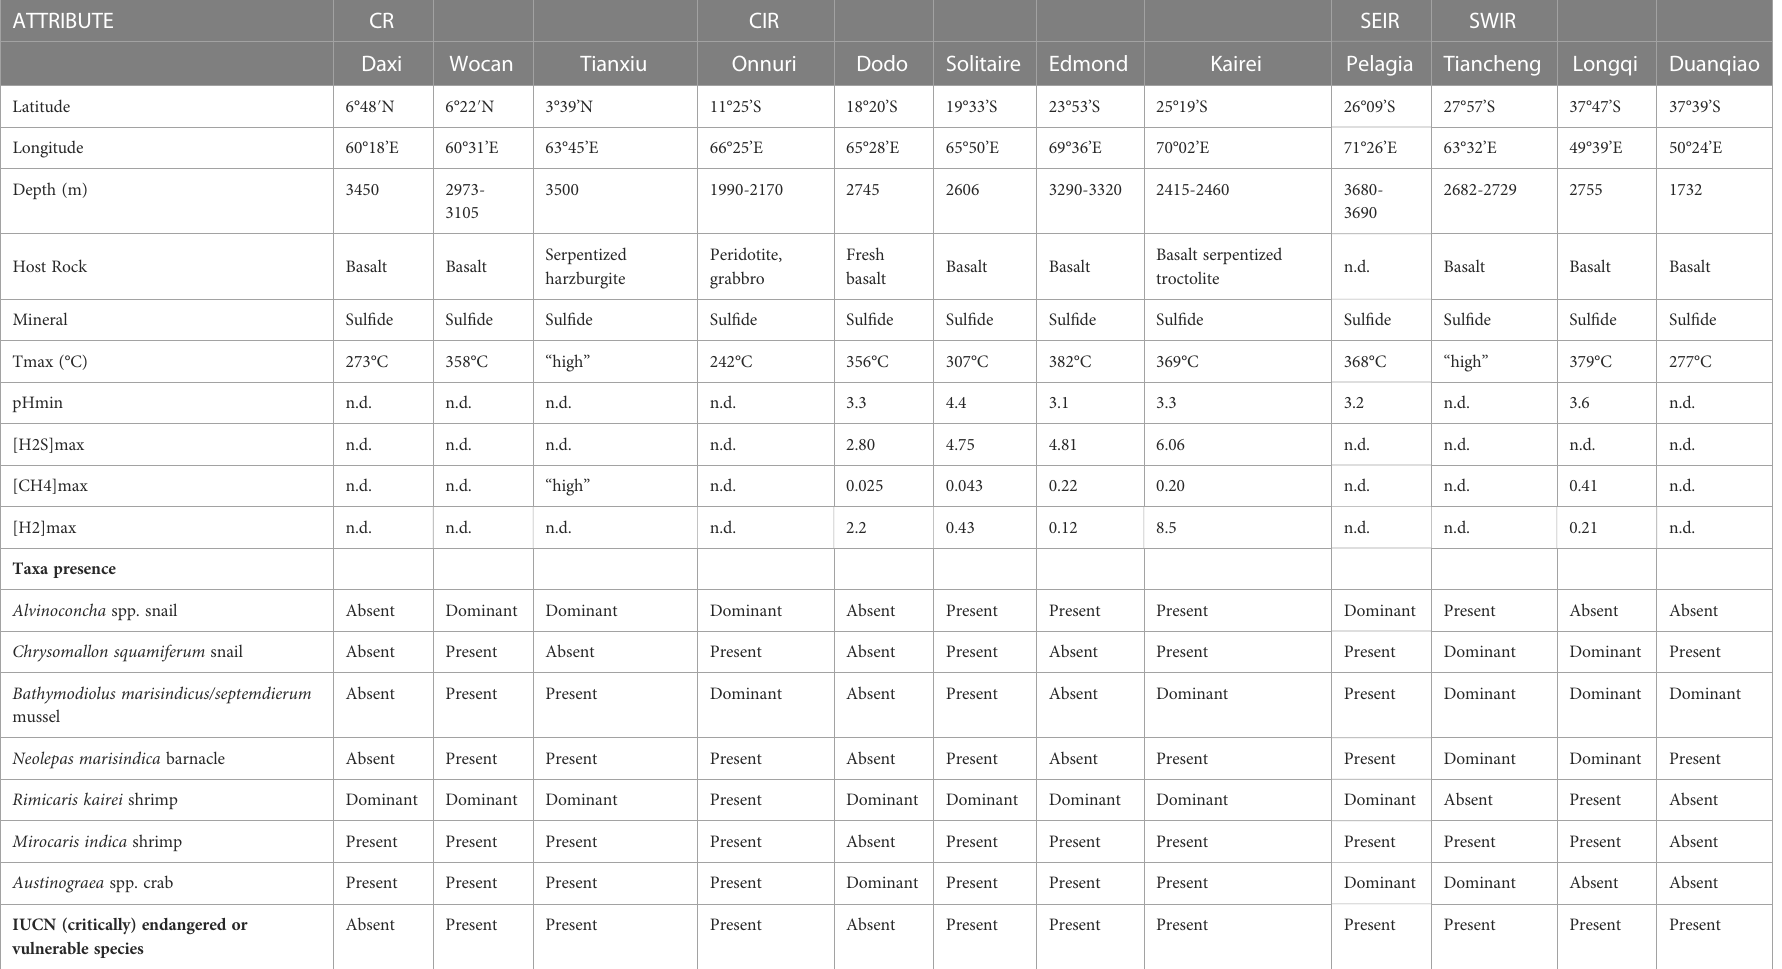
TABLE 1 Selected attributes of 12 active vent fi elds in the Indian Ocean, based on the literature used in this review. ATTRIBUTE